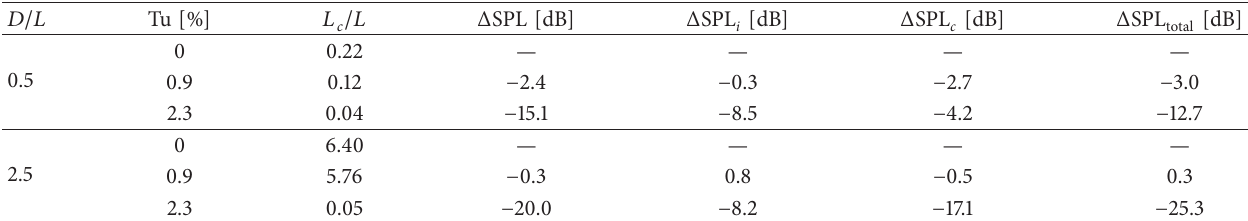
Table 2: Contributions of intensity and spanwise coherence of sound source to the sound pressure